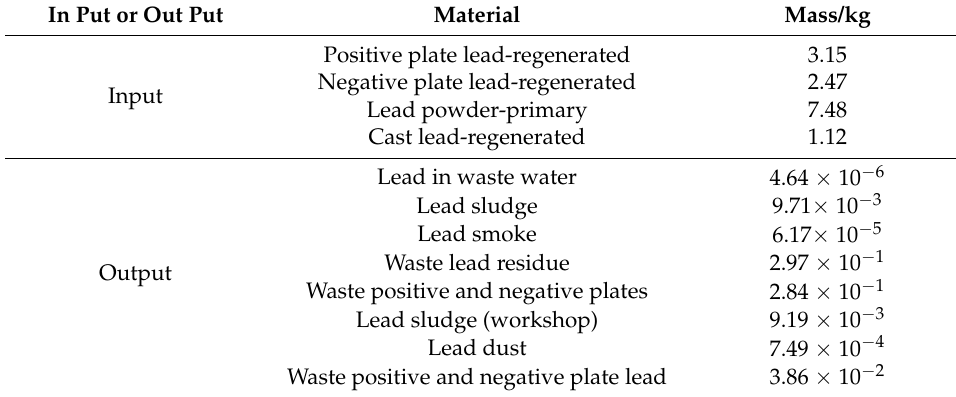
Table 2. The input and output of lead for 1 KVAh lead-acid batteries.